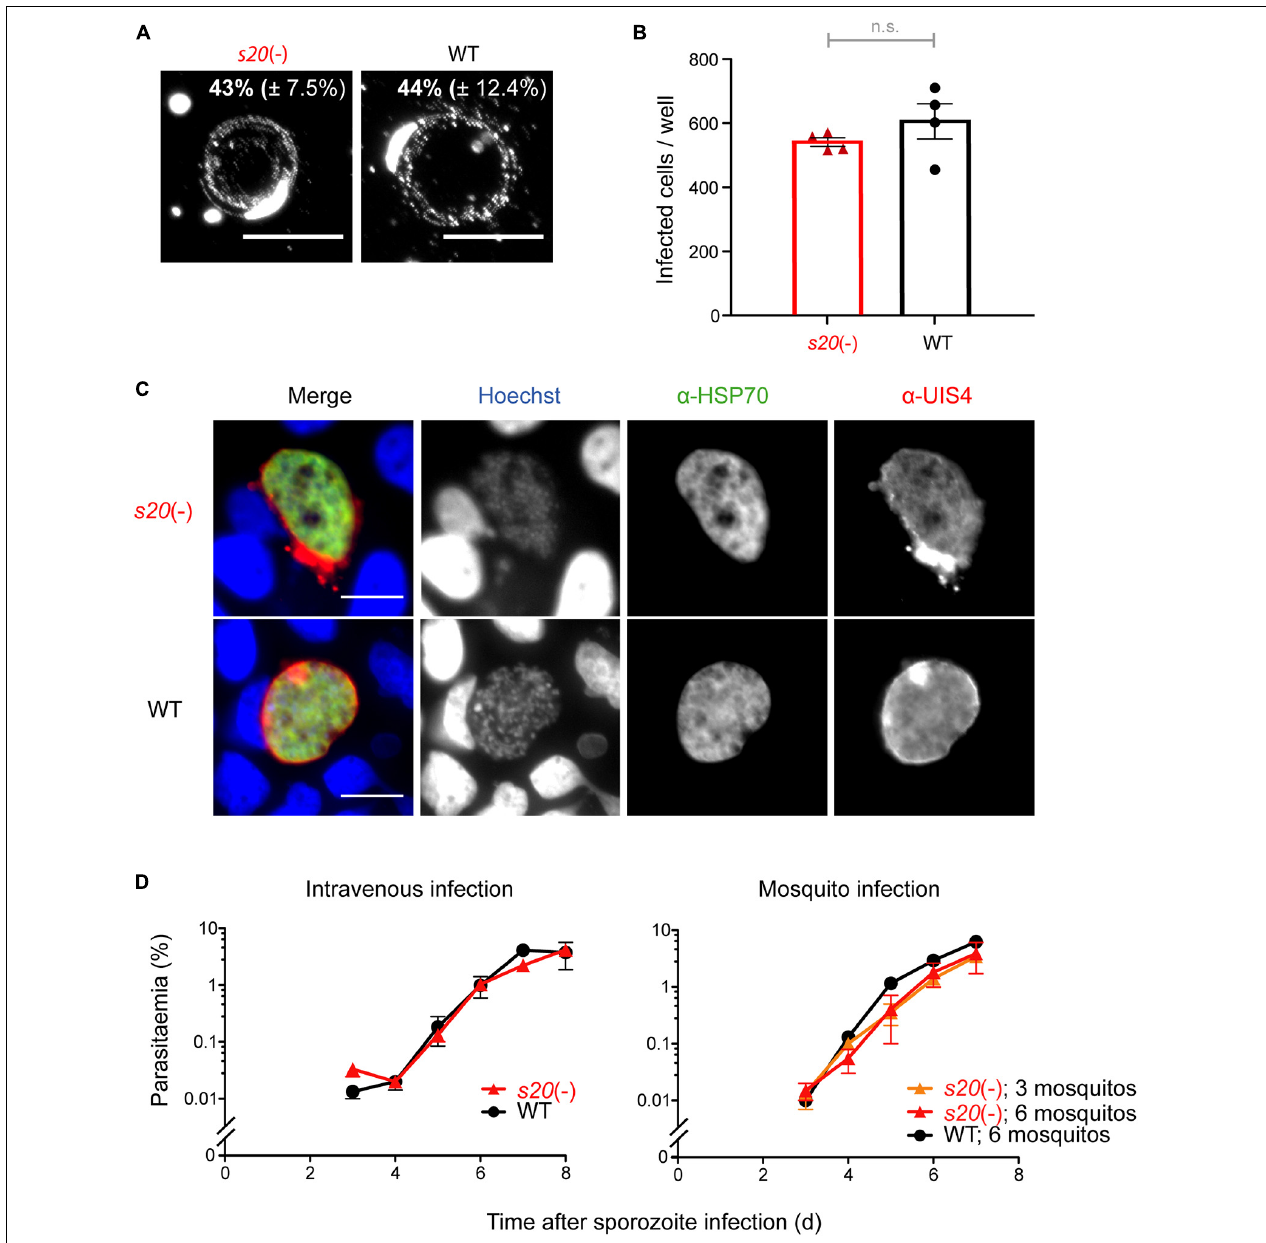
FIGURE 3 | Normal life cycle progression of s20 (-) parasites. (A) Fluorescence micrographs of s20 (-) and WT sporozoites that were permitted to glide on BSA-coated glass slides. Sporozoites and trails are visualized with an anti- Pb CSP and anti-mouse secondary antibodies. Numbers show mean percentage ( ± SD) of gliding sporozoites. (B) Quantification of s20 (-) and WT-infected hepatoma (Huh7) cells by fluorescence microscopy 48 h after infection. Shown are mean values ( ± SEM); n = 1; n.s., non-significant (unpaired t -test). (C) Representative fluorescence images of s20 (-) and WT liver stages. α -HSP70 antibody (green; parasite cytoplasm), α -UIS4 antibody (red; parasitophorous vacuole), and Hoechst (blue; nucleic acid). Scale bars, 10 µ m. (D) Blood infection after sporozoite-induced infection. B6 mice were infected by intravenous injection of 10,000 s20 (-) or WT sporozoites ( n = 3 each) or mosquito bites (WT, six infected mosquitoes, n = 1; s20 (-), 3 or 6 infected mosquitoes, n = 2 each). Blood infection was monitored by daily microscopic examination of Giemsa-stained blood films. Shown are mean values ( ± SEM).